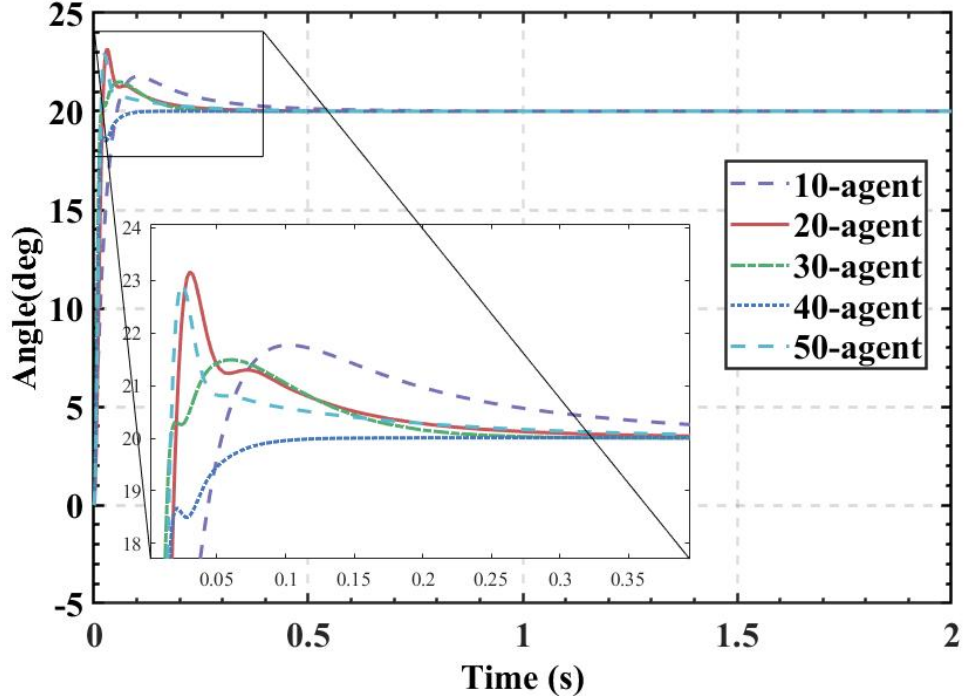
Figure 10. The actual angle of the balancing robot under WOA-PID algorithm.